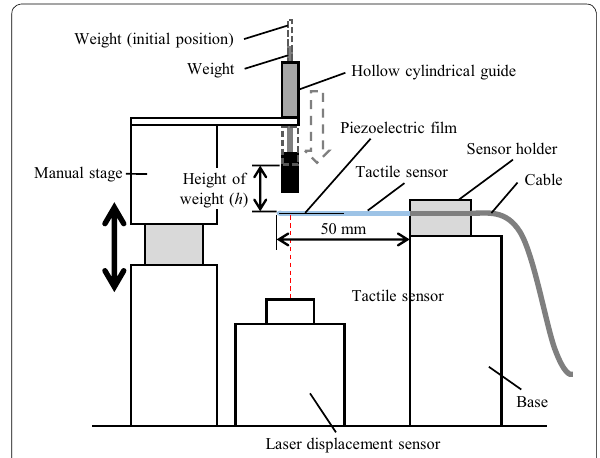
Fig. 7 Experimental apparatus for the weight-drop test to evaluate the prototype